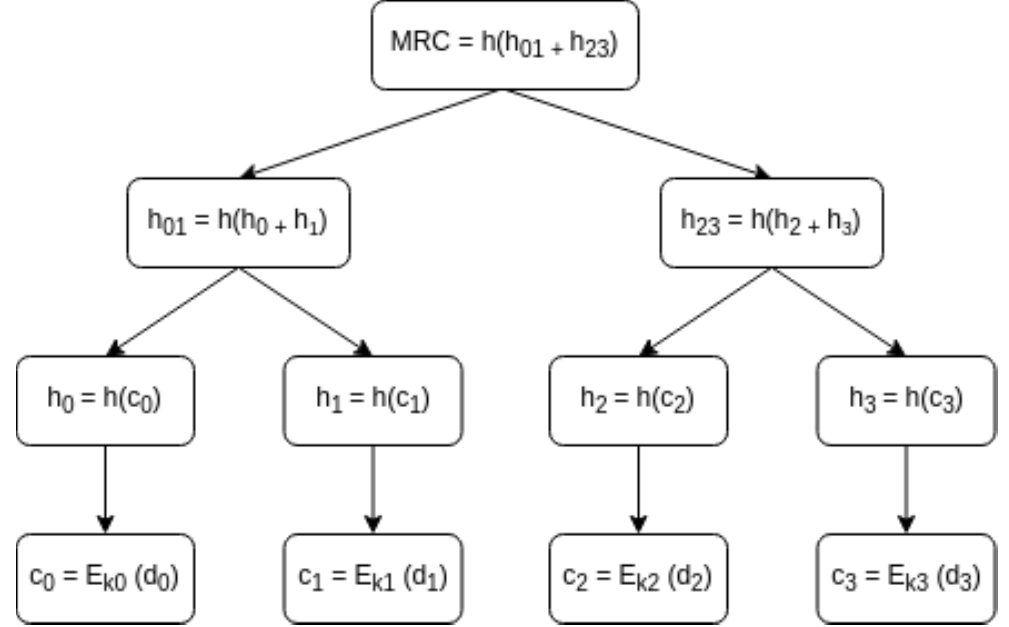
Figure 5. Tree of cryptograms MHT ( C ) . In this example, MRC = H 0123